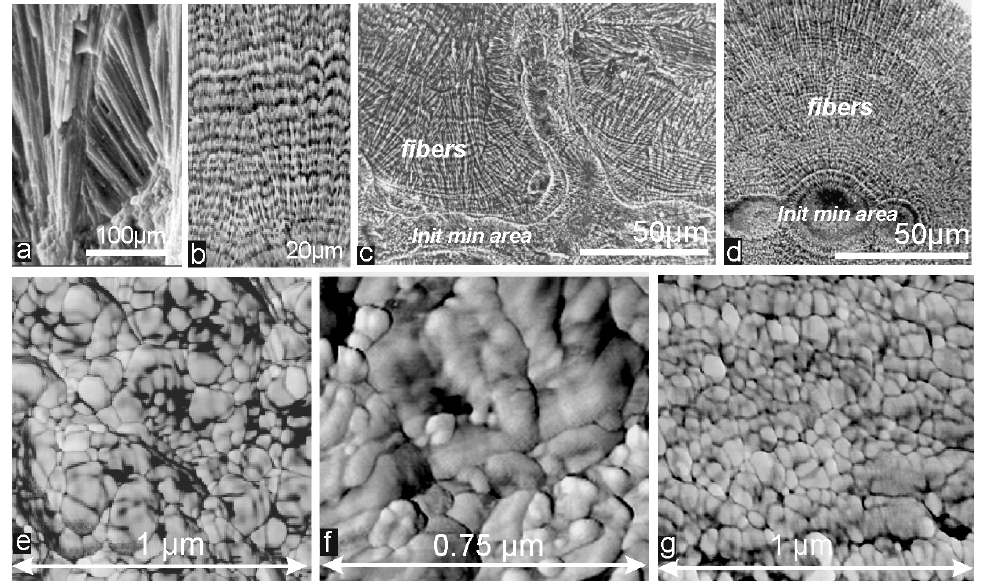
Figure 13. Layered growth of fibers ( a – d ); and nano-scaled granular structure of the growth layers in DSSC and DSOC ( e – g ). ( a ) The crystal-like fibers observed on a surface fracture of a Sleractinia skeleton ( Caryophyllia sp.); ( b ) polished and etched section showing the layered growth mode of fibers (same species); ( c , d ) examples of layered growth mode in the skeleton for Favia ( c ) and Diploria ( d ); ( e ) nanometer-scaled grains in fibers of recent Scleractinia; and ( f , g ) permian fossil coral (( f ) Calophyllum ); and Bamboo coral (( g ) Isididae).